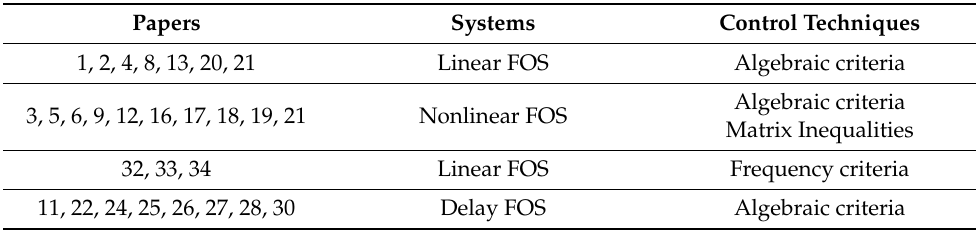
Table 1. Control